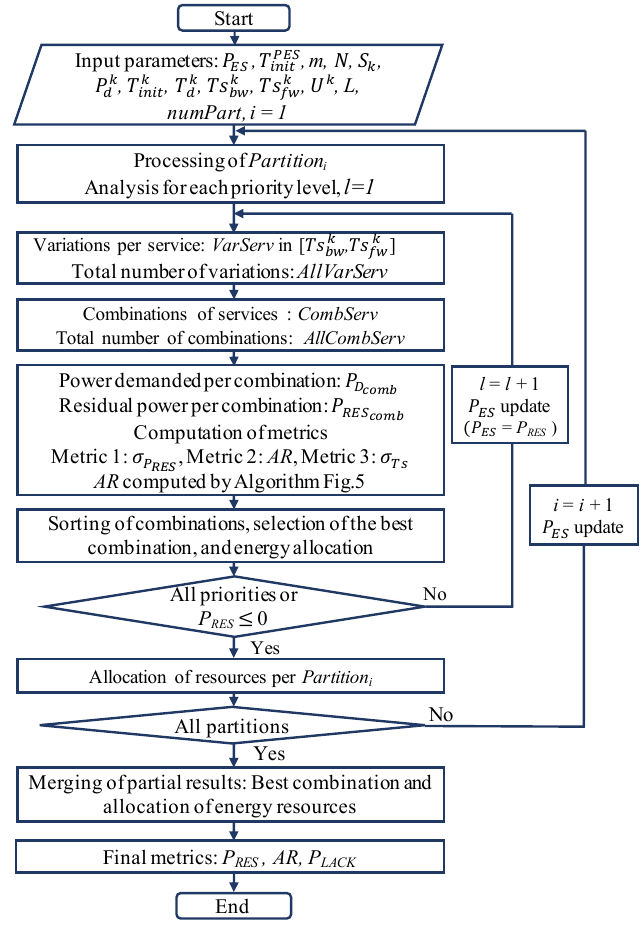
Figure 9. Flow chart of the heuristic